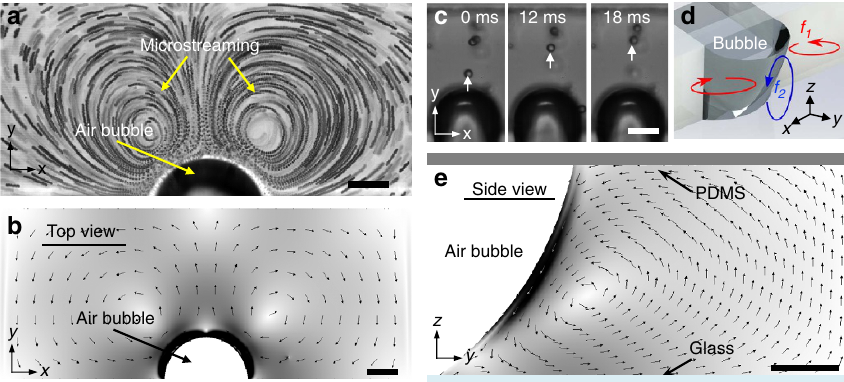
Figure 2 | Experimental and numerical demonstration of acoustic microstreaming. ( a ) An optical image of acoustic microstreaming in the x-y plane during microbubble oscillation at a driving frequency of 24kHz and voltage of 10V pp . ( b ) A simulation of microstreaming from the x-y plane (top view) of the microbubble. ( c ) An optical image of out-of-plane (perpendicular to the x-y plane) microstreaming during microbubble oscillation at 25.5kHz and 15V pp . ( d ) 3D sketch demonstrating in-plane (marked in red) and out-of-plane (marked in blue) acoustic microstreaming vortices at frequency f 1 and f 2 , respectively. ( e ) A graphic simulation illustrating microstreaming in the y-z plane (side view) of an asymmetric microbubble. Scale bars ¼ 30 m m. In both b and e , the arrows indicate the direction of the streaming velocity, while the colour plot shows the magnitude of the streaming velocity ranging from white (min) to black